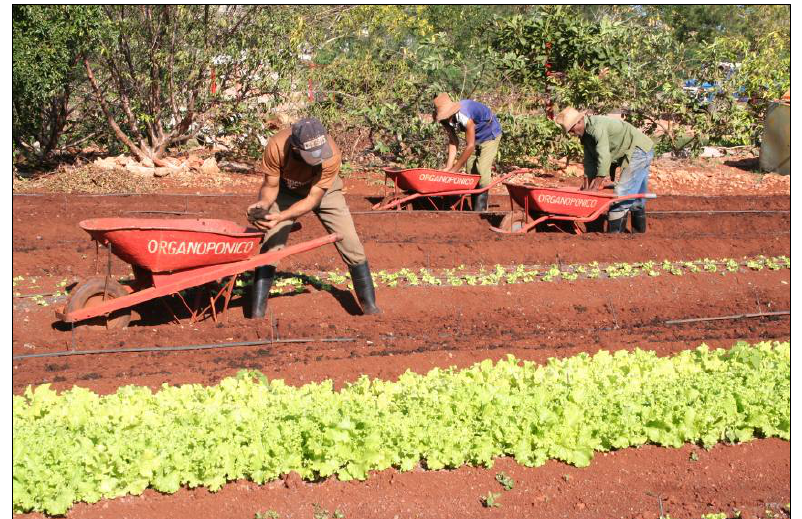
Figure 1. Members of a UBPC-managed organoponico in Havana lay composted material on raised beds.